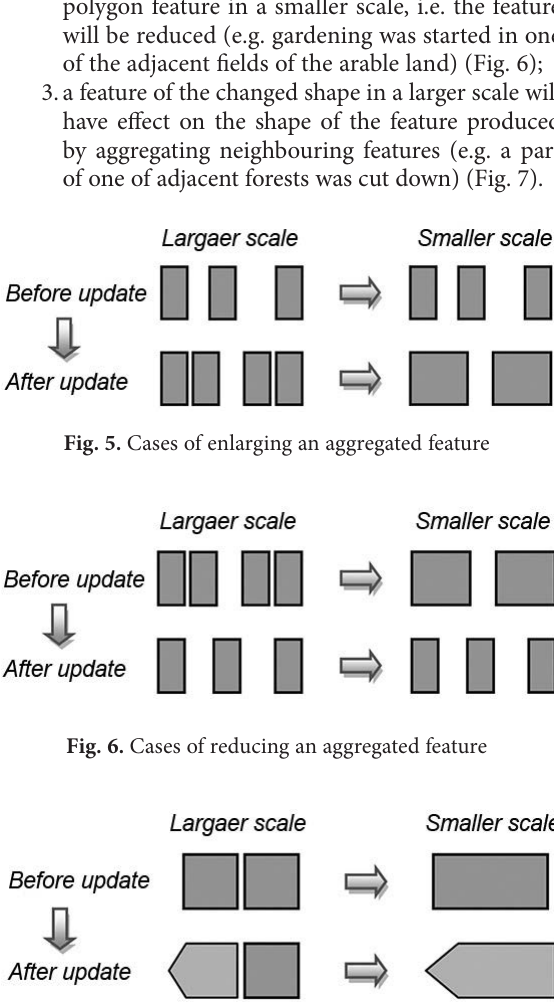
Fig. 7. Cases of changing the shape of an aggregated